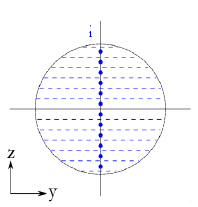
Fig. 1. Rotor disk area, segmented for use with a vertical velocity profile Using the 10 minute intervals where the U DA falls between each velocity bin the fluctuation intensity is determined at the hub height of each rotor. The fluctu- ation intensity is determined using Equation 2, which is usually used to determine the turbulence